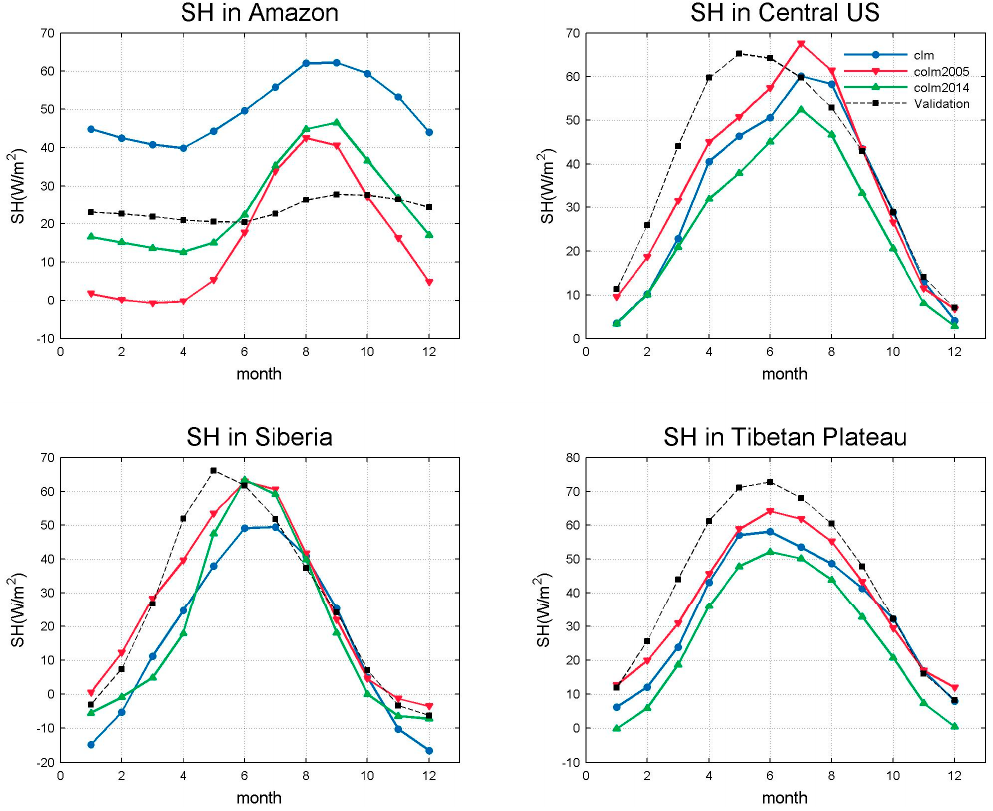
Figure 13. Same as Figure 3, but for sensible heat flux (Units: W m − 2 ). Table 6. Statistical summary of simulated sensible heat flux annual cycles.